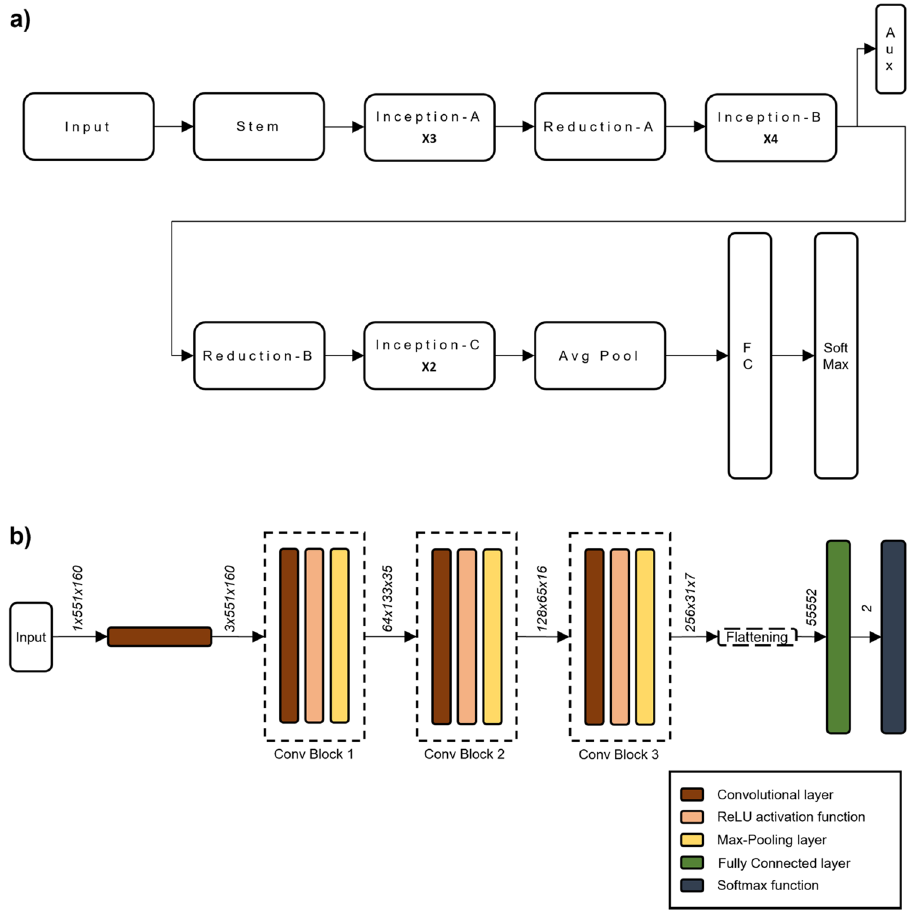
Figure 10. ( a ) Inception-v3 architecture. It includes three types of Inception modules, two of which perform the factorization of convolutions, both in smaller (Inception-A) and asymmetric convolutions (Inception-B), while the third type expands the filter bank outputs to promote high dimensional representations (Inception-C). This CNN exploits an auxiliary classifier (AUX) as a regularizing element and an efficient grid size reduction (Reduction-A and Reduction-B) by concatenating the feature maps obtained from convolutions with stride 2 and from max-pooling operation. Each convolutional layer is followed by batch normalization and Rectified Linear Unit (ReLU) activation function. ( b ) Optimized CNN architecture. The output tensor dimension of each layer (marked in Italics) is in the form number of channels, height,